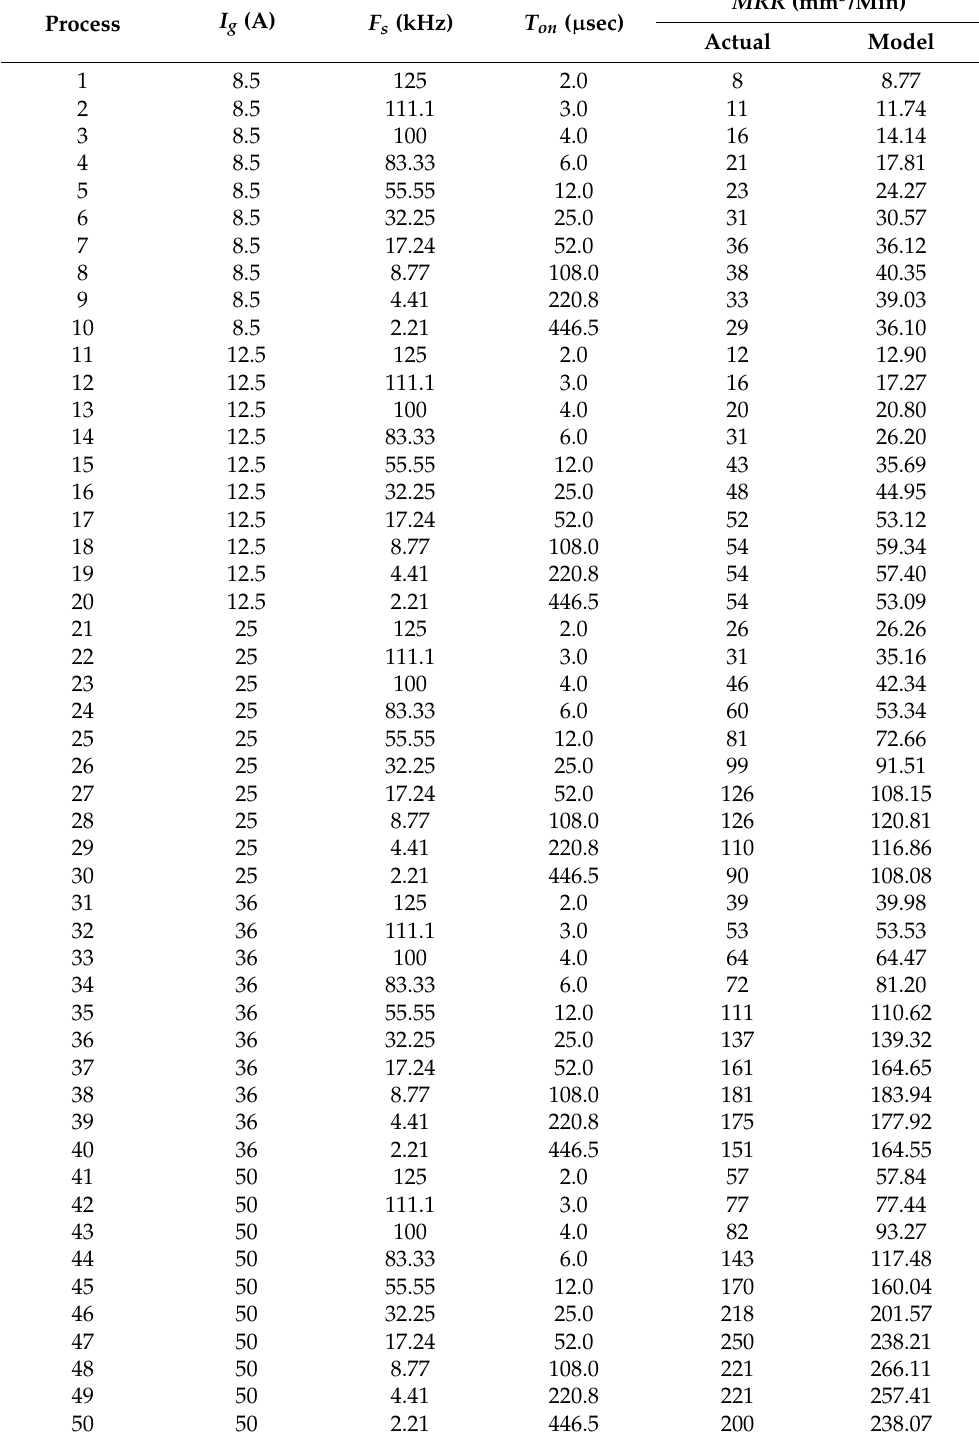
Table 2. EDM process and model